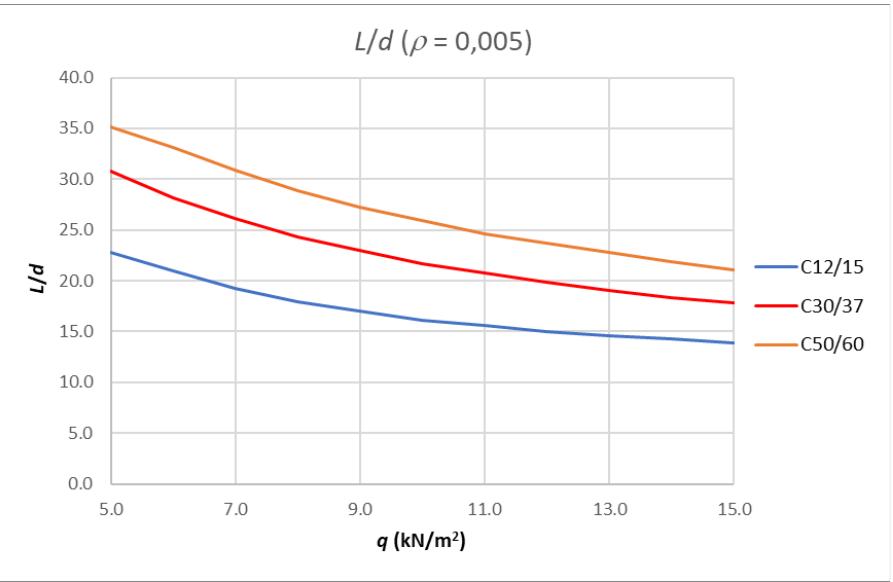
Figure 9. Results of analysis-limit span to depth ratio depending on amount of load for fixed reinforcement ratio and different concrete class.